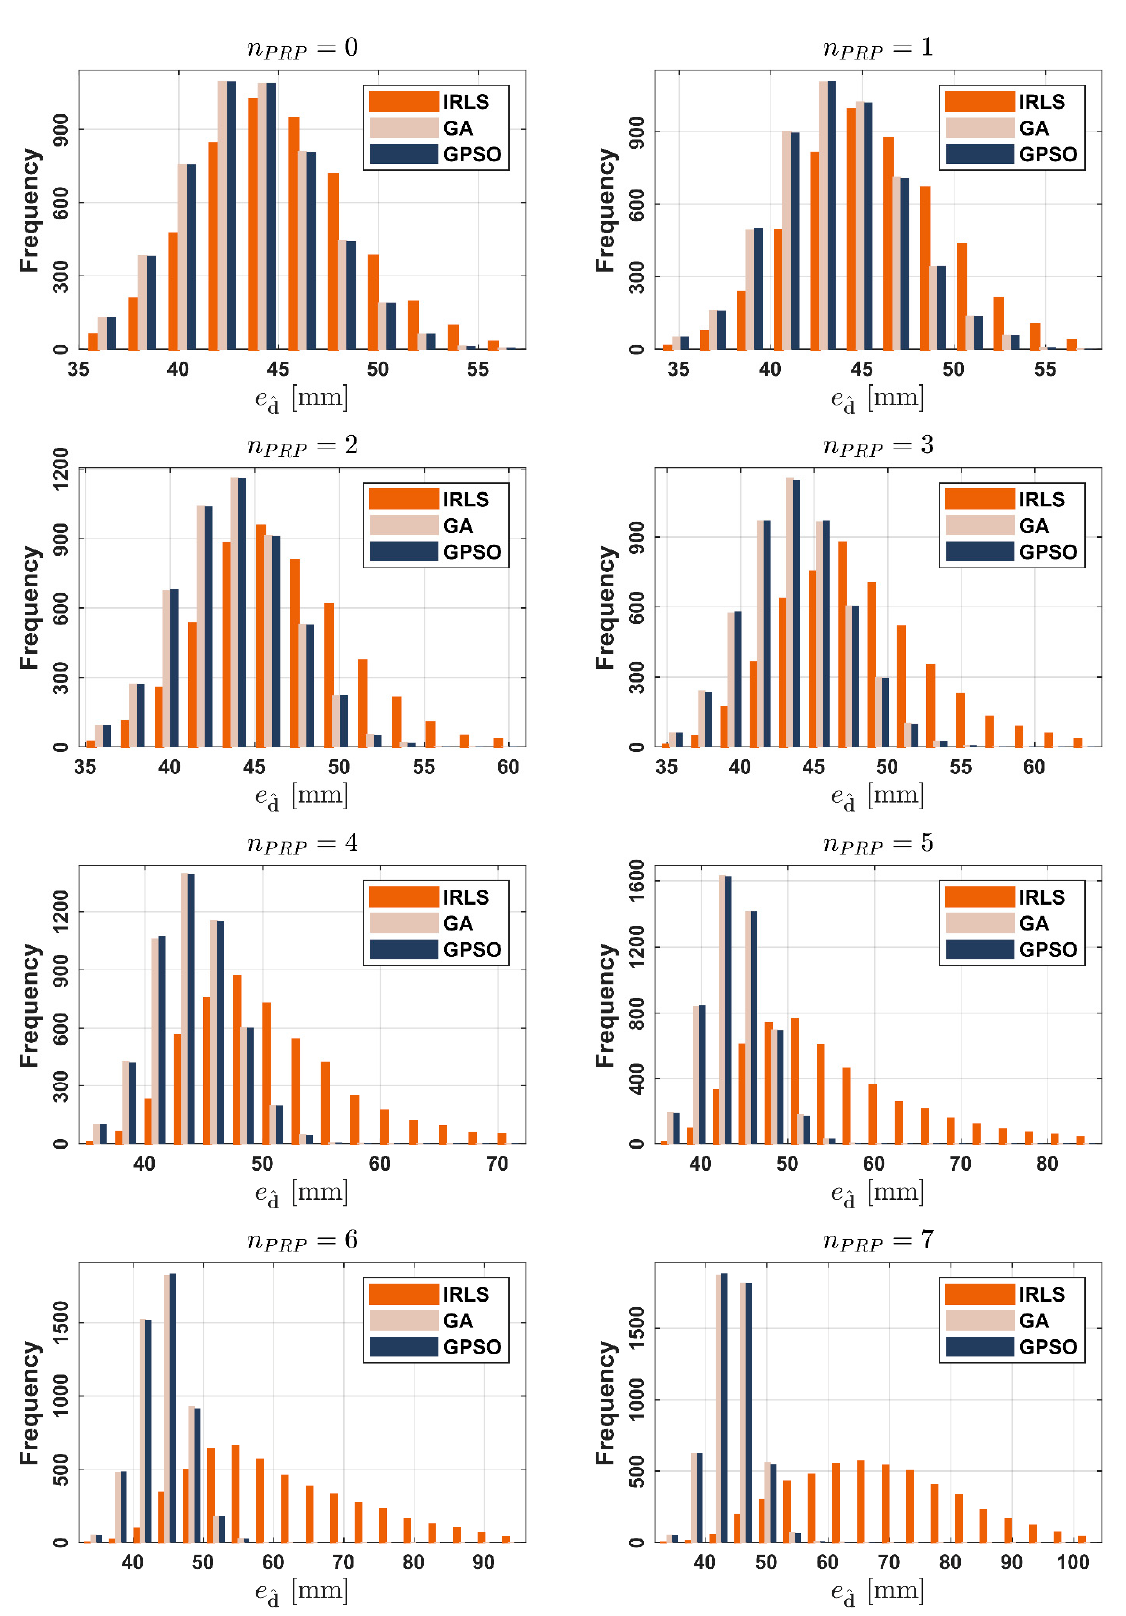
Figure A1. Empirical distributions of overall absolute true errors 𝑒 𝐝(cid:4632) for variant 1.